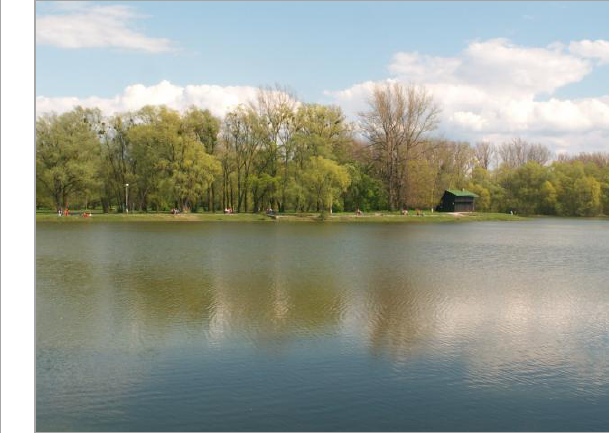
Fig. 5. The Karviná – Lipiny Golf Resort was created in the devastated landscape between two operating mines ( J. Havrlant , 2014)